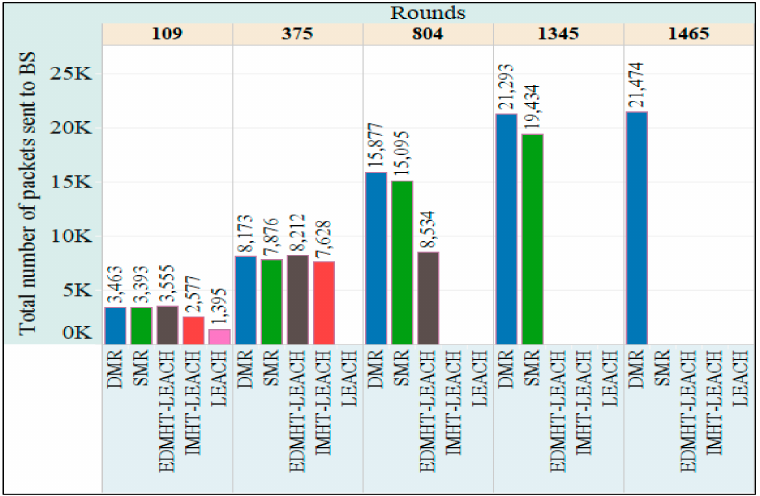
Figure 14. The total number of packets sent to Base Station (BS) in the DMR, SMR, EDMHT-LEACH, IMHT-LEACH and conventional LEACH approaches versus the